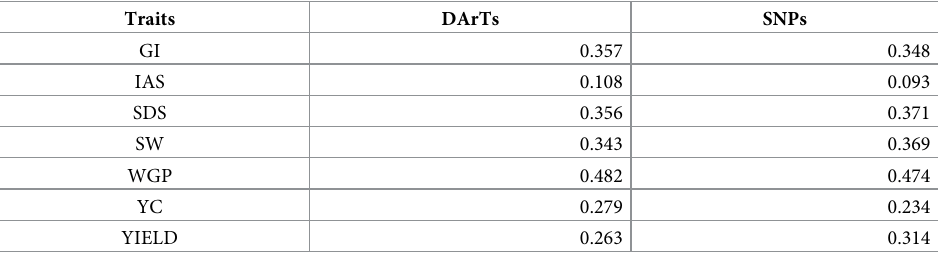
Table 5. Genomic selection (GS) prediction ability results for the assessed traits using DArT and SNP